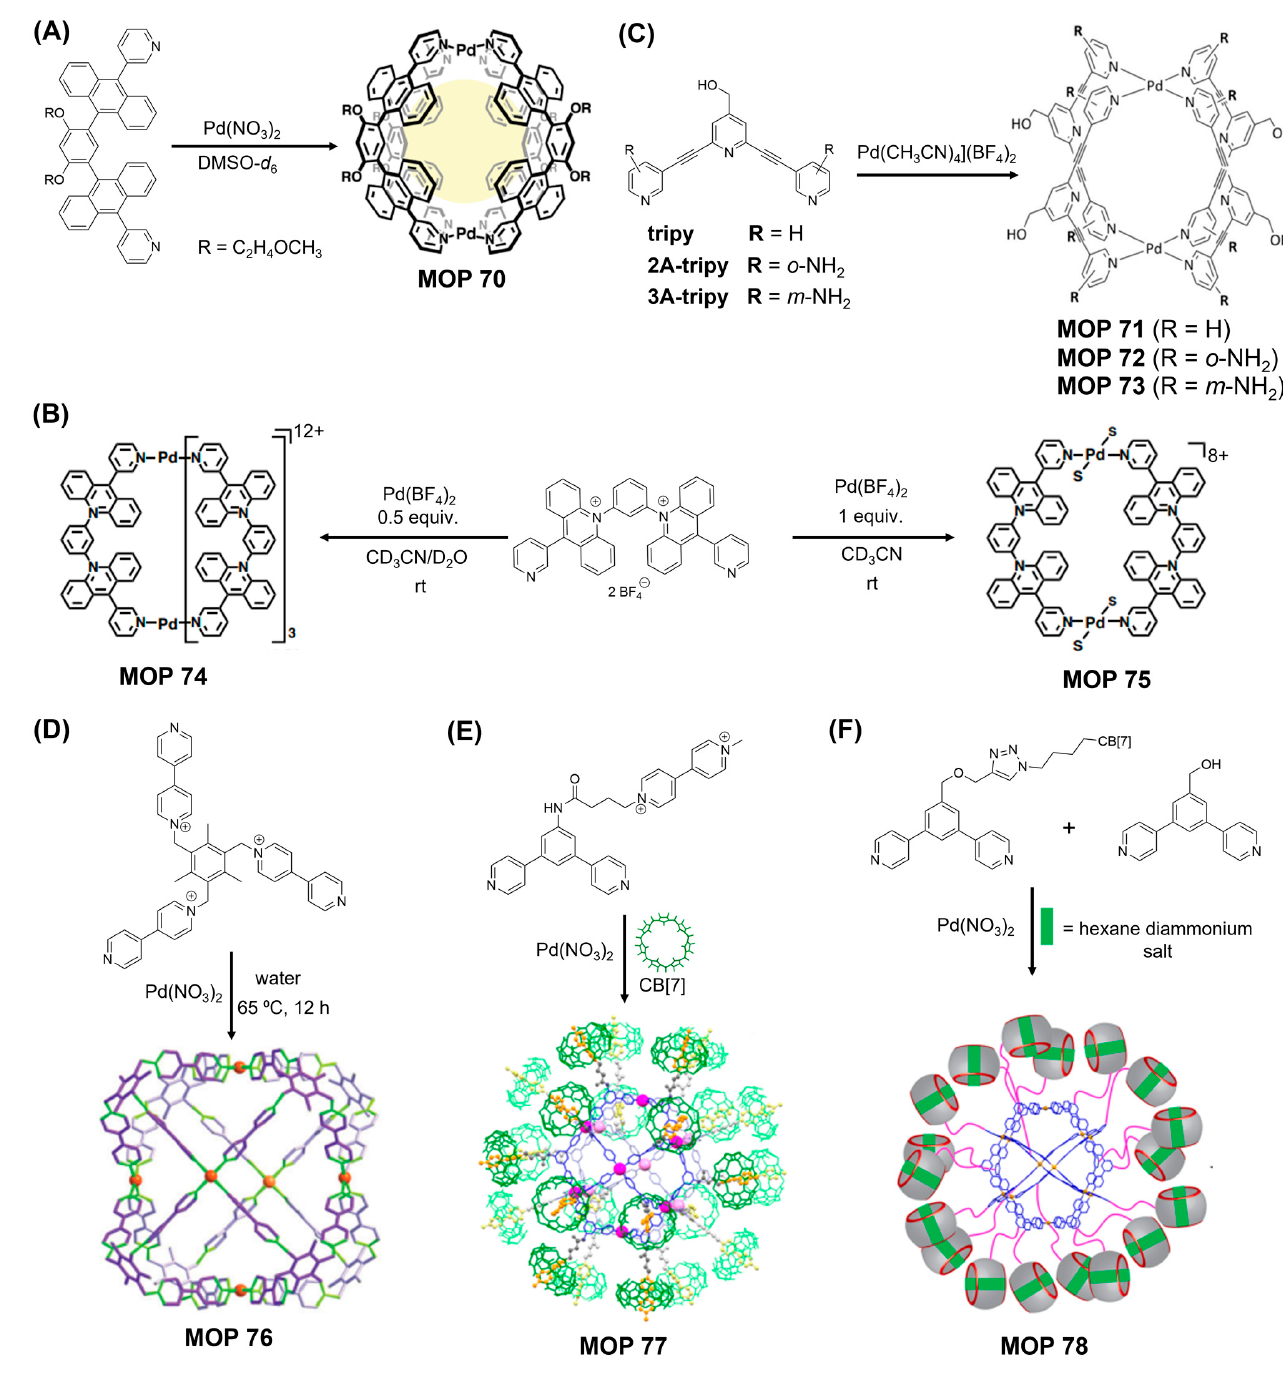
Figure 25. ( A ) Schematic representation of the self-assembly of capsule MOP 70. ( B ) Schematic representation of dodecacationic M 2 L 4 capsule MOP 74 and octacationic M 2 L 2 cube MOP 75. ( C ) Schematic representation of the synthesis of capsule MOP 71, MOP 72 and MOP 73. ( D ) Preparation of MOP 76 in water via molecular self-assembly. ( E ) Multicomponent self-assembly of CB[7] capped cuboctahedron cage, MOP 73. ( F ) Mixed ligand co-assembly of cuboctahedron cage MOP 78. CB[7] cavity is occupied by hexanediammonium salt. Reprinted by permission from Refs. [199,202,204–207]. Copyright 2011, 2016 and 2017 from American Chemical Society. Copyright 2016 from Royal Society of Chemistry. Copyright 2016 from Wiley-VCH.